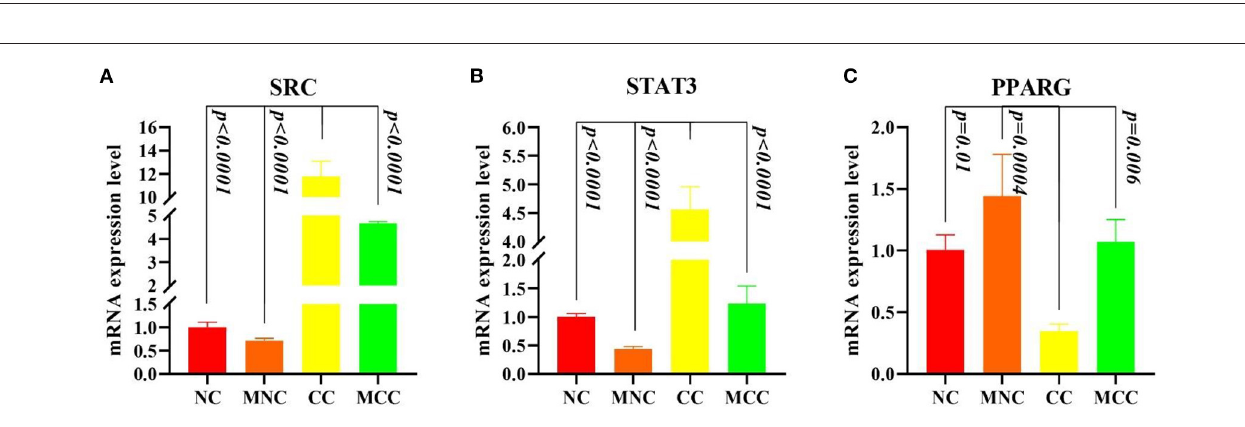
FIGURE 8 | (A–C) Expression levels of Hubba gene mRNA. (A) Expression levels of SRC mRNA expression level. (B) Expression levels of STAT3 mRNA expression level. (C) Expression levels of PPARG mRNA expression level. The difference was significant if p < 0.05 compared to the control